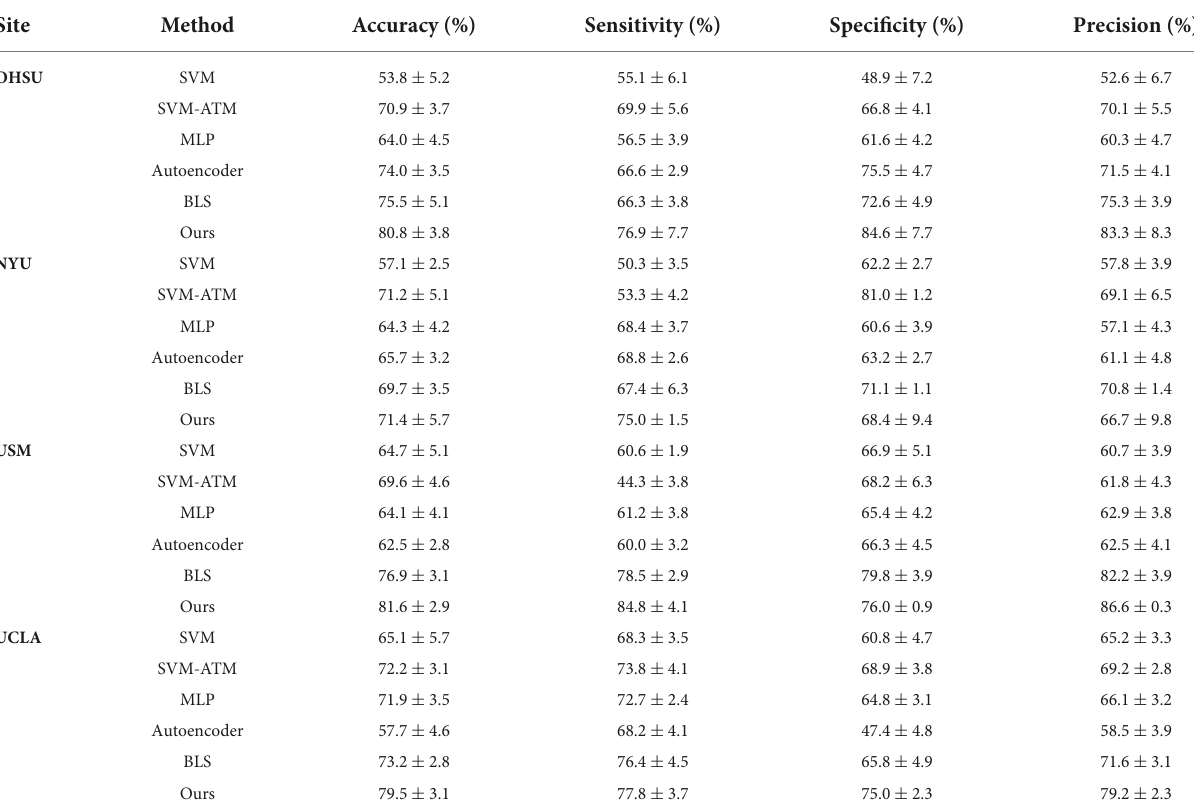
TABLE 4 Classification performance of ASD identification achieved by six different methods on four datasets ( i.e. , OHSU, NYU, USM and UCLA) with rs-fMRI